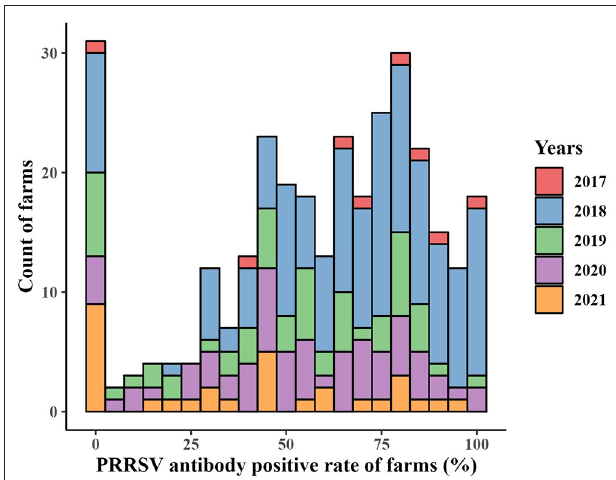
FIGURE 2 | Histogram of PRRSV prevalence of pig farms from December 2017 to May